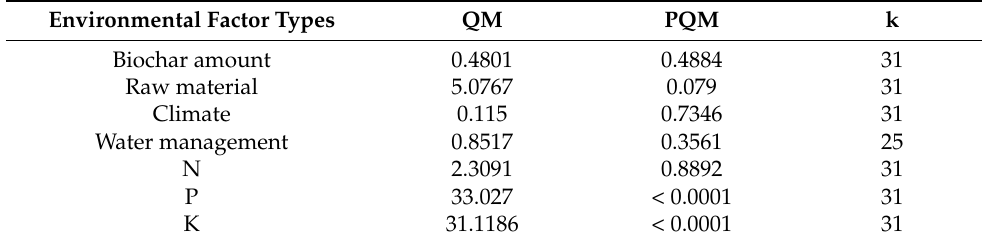
Table 5. Factors affecting N 2 O emissions from paddy soils under biochar incorporation.